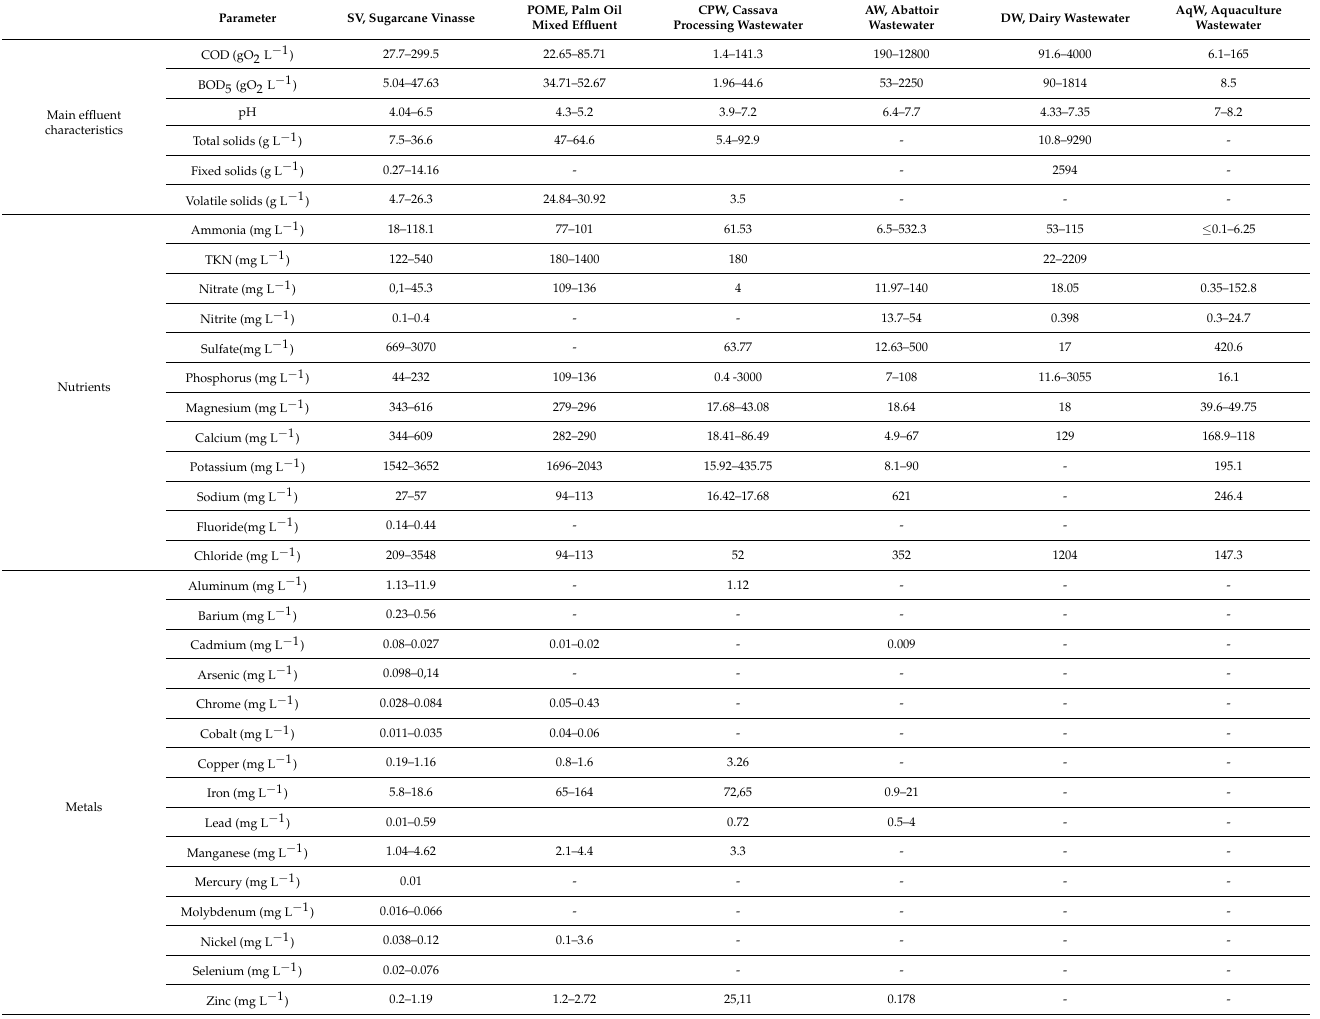
Table 1. Physical-chemical composition of agro-industrial effluents that are produced in large